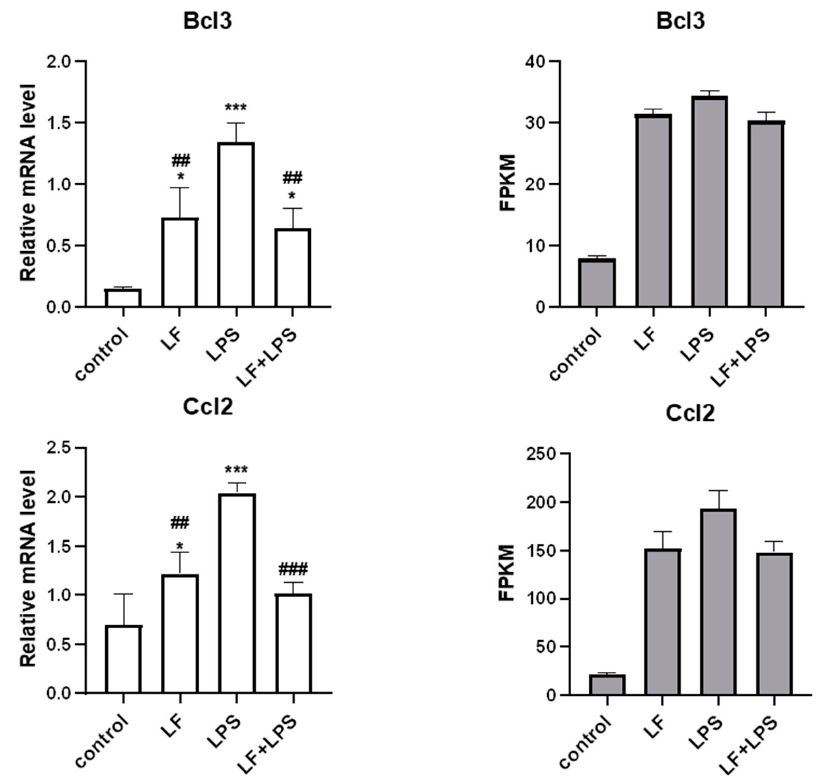
Figure 4. RT-qPCR and RNA-seq were used to determine the expression levels of inflammation- related genes. LF represents apo-LF. Apo-LF represents individual treatment with 10 g/L apo-LF, LPS represents individual treatment with 1 mg/L LPS and apo-LF + LPS represents combined treatment with of 10 g/L apo-LF and 1 mg/L LPS. Data analyzed were presented as means ± SD. * means comparison with the control group, * p < 0.05, ** p < 0.01, *** p < 0.001. # means comparison with the LPS group, # p < 0.05, ## p < 0.01, ### p < 0.001.